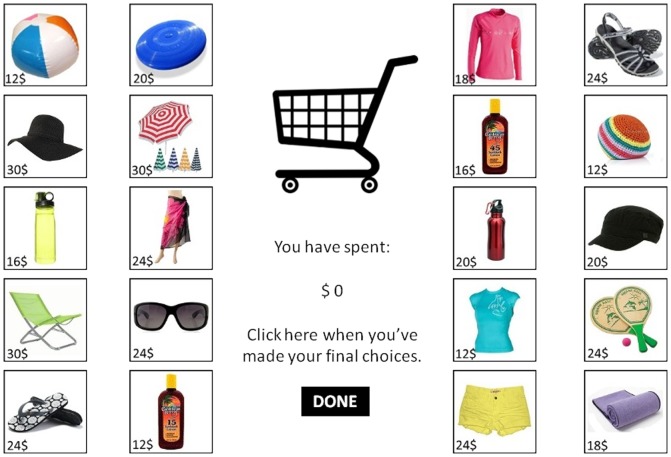
Lost luggage game.